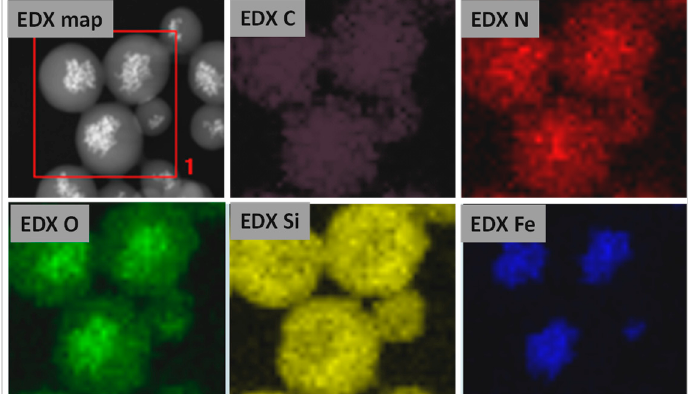
Figure 7. EDX-mapping analysis of magnetic chiral PMO nanoparticles.